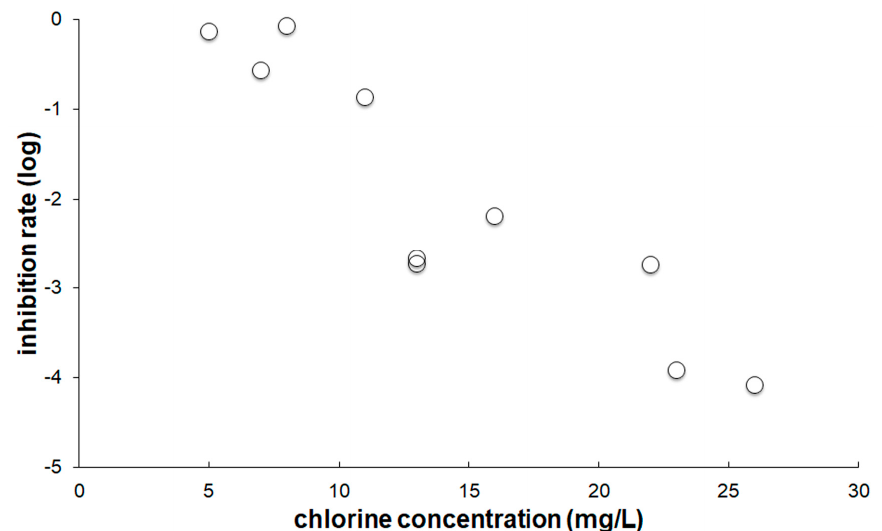
Figure 2. In vitro disinfection activity of SAEW on E. coli . The inhibition rate was evaluated by dividing the number of cells treated with SAEW by those treated with